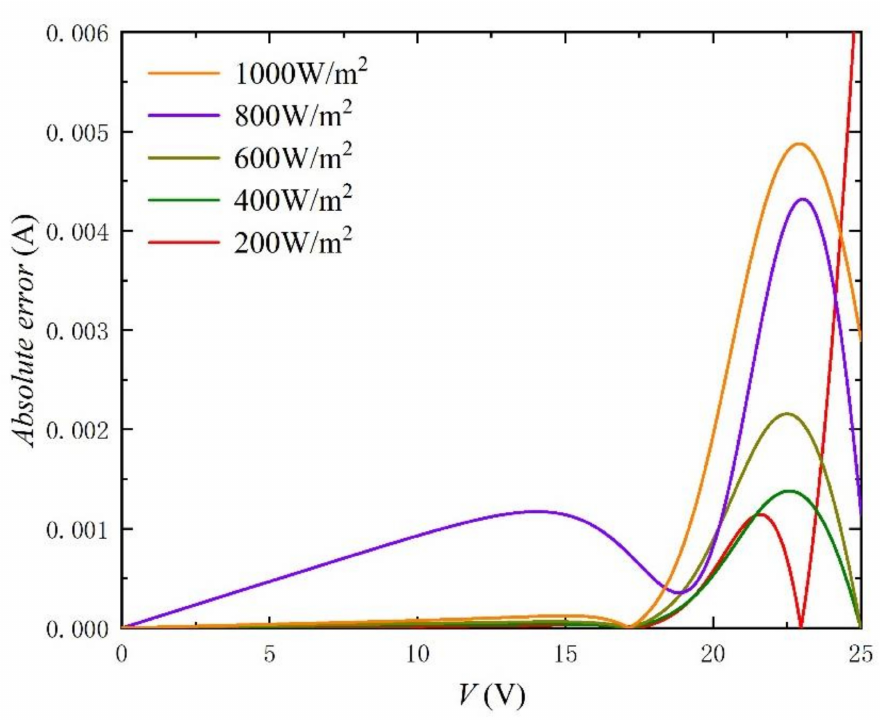
Figure 11. Absolute error curves between experimental data [33] and calculation results by using the extracted parameters listed in Table 3.